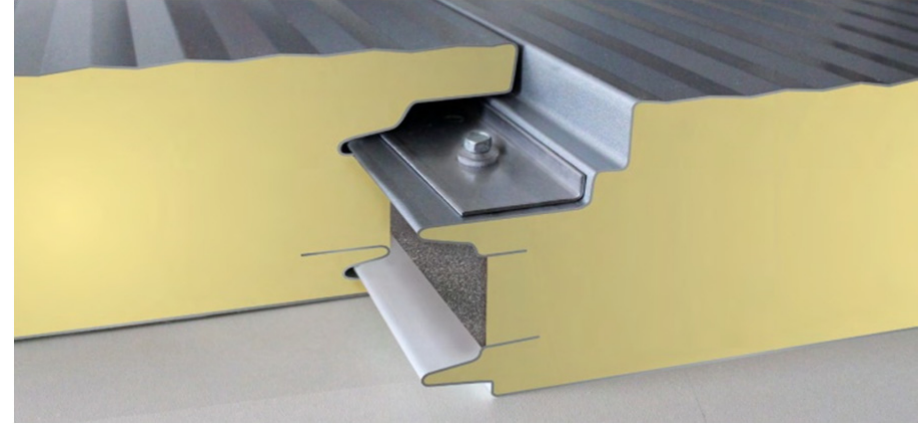
Fig. 2 Elevation through Brucha FP-P sandwich panel with PUR core, steel sheets and invisible fixation (special groove and tongue milling, and fixation clip for invisible fixing, © Brucha).